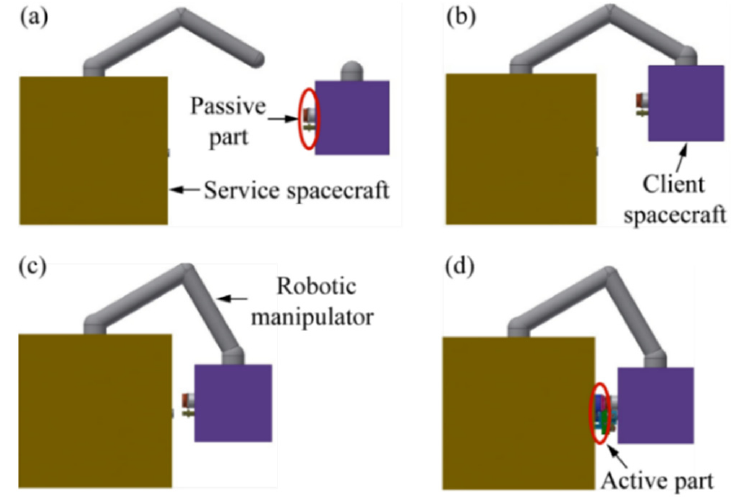
Figure 1. Steps of berthing and joining by stretching: ( a ) approach, ( b ) capture, ( c ) pullback, ( d ) docking.